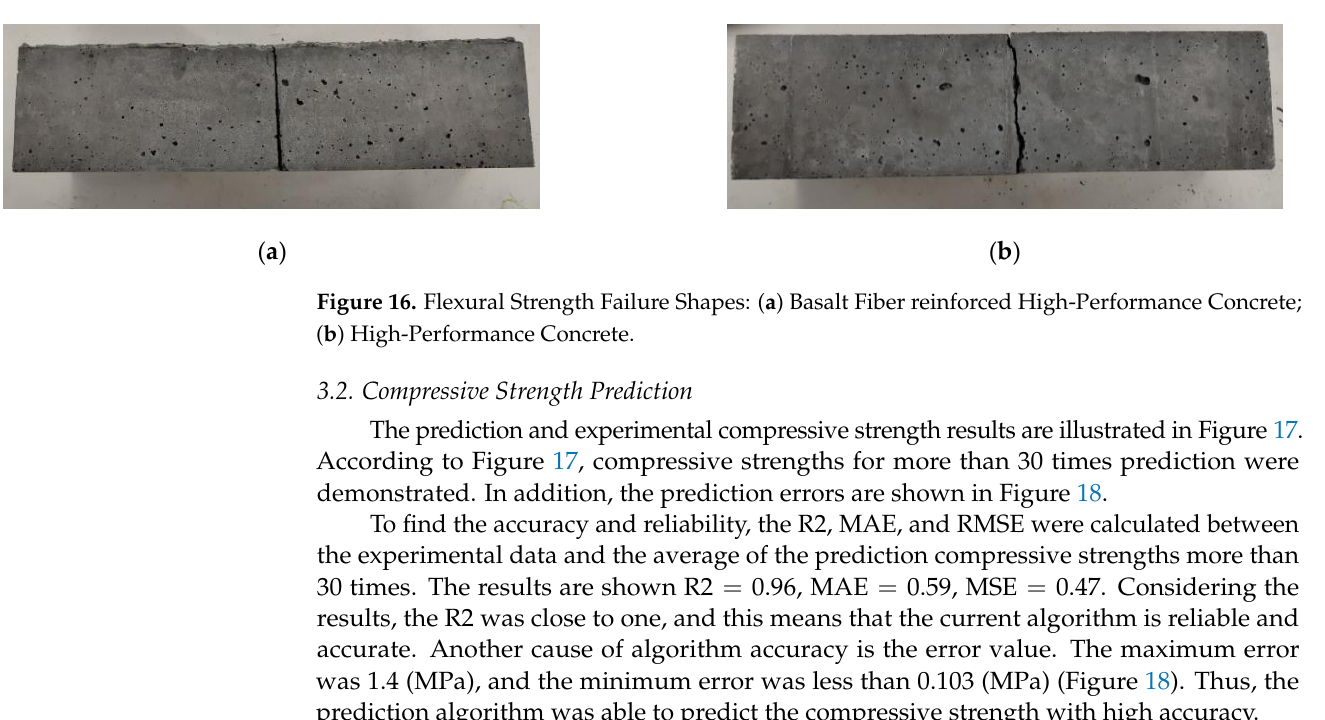
Figure 17. Compressive Strength Prediction, and Experimental Data. 90929496